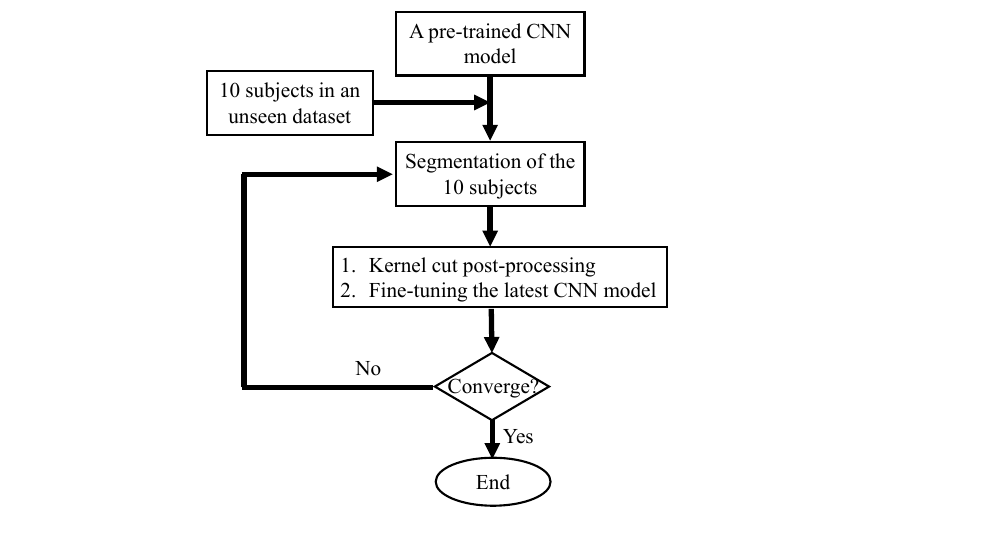
Figure 1. Schematic of the proposed algorithm pipeline for cardiac MR image segmentation using pre- trained CNNs. A trained CNN was applied to 10 previously unseen subjects; the initial segmentation was post-processed and post-processed using a kernel-cut algorithm. The resulting segmentation was used to update the trained CNN. This procedure was iterated till convergence to derive the final CNN model, which was applied to the unseen test dataset for LV function evaluation. Please note that no manual annotation of the unseen dataset was required in this